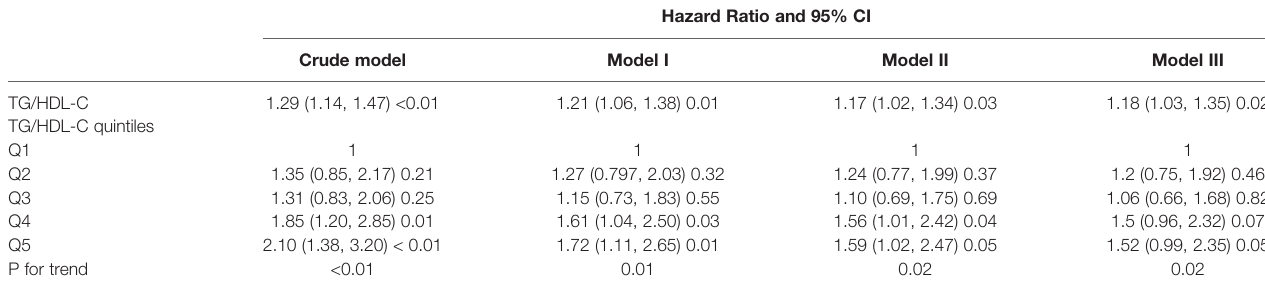
TABLE 2 | Multivariate analysis for the relationship between TG/HDL-C ratio and incident T2DM.